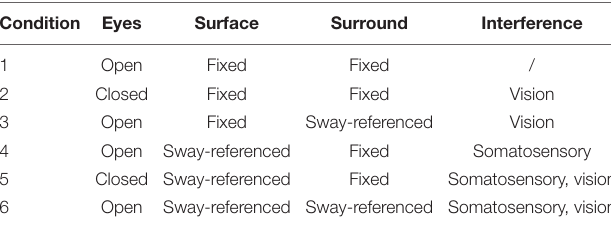
TABLE 1 | Sensory organization